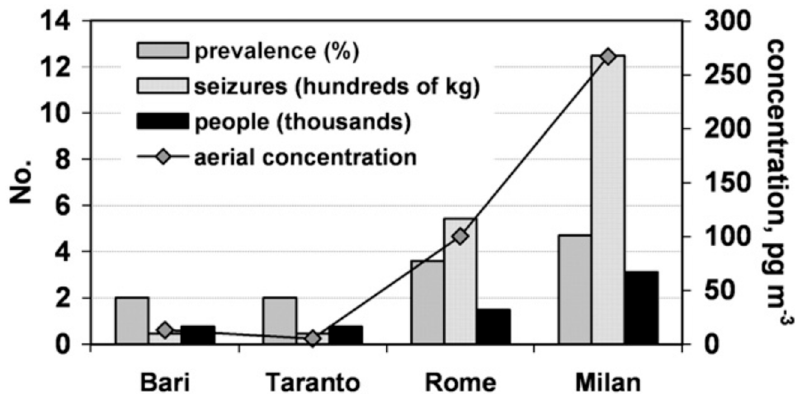
Figure 1. The rates of the prevalence of abuse, the amount of cocaine seized, number of people involved in criminal activity associated with cocaine, and the airborne concentrations of cocaine in four Italian cities. With permission from [39].